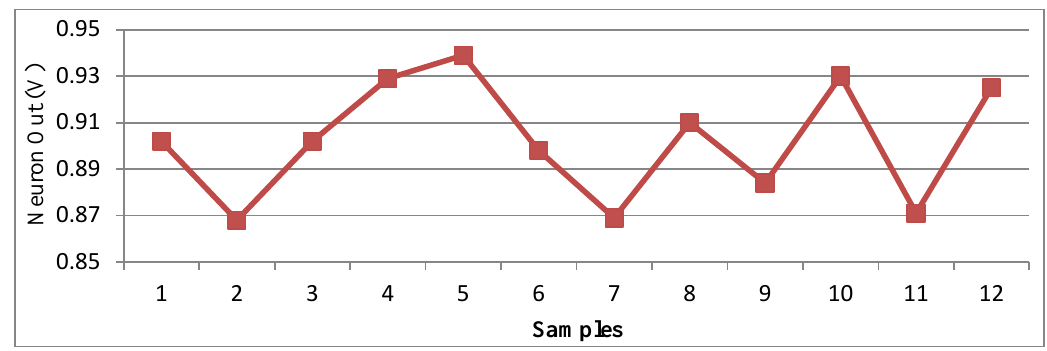
Figure 15. Classification